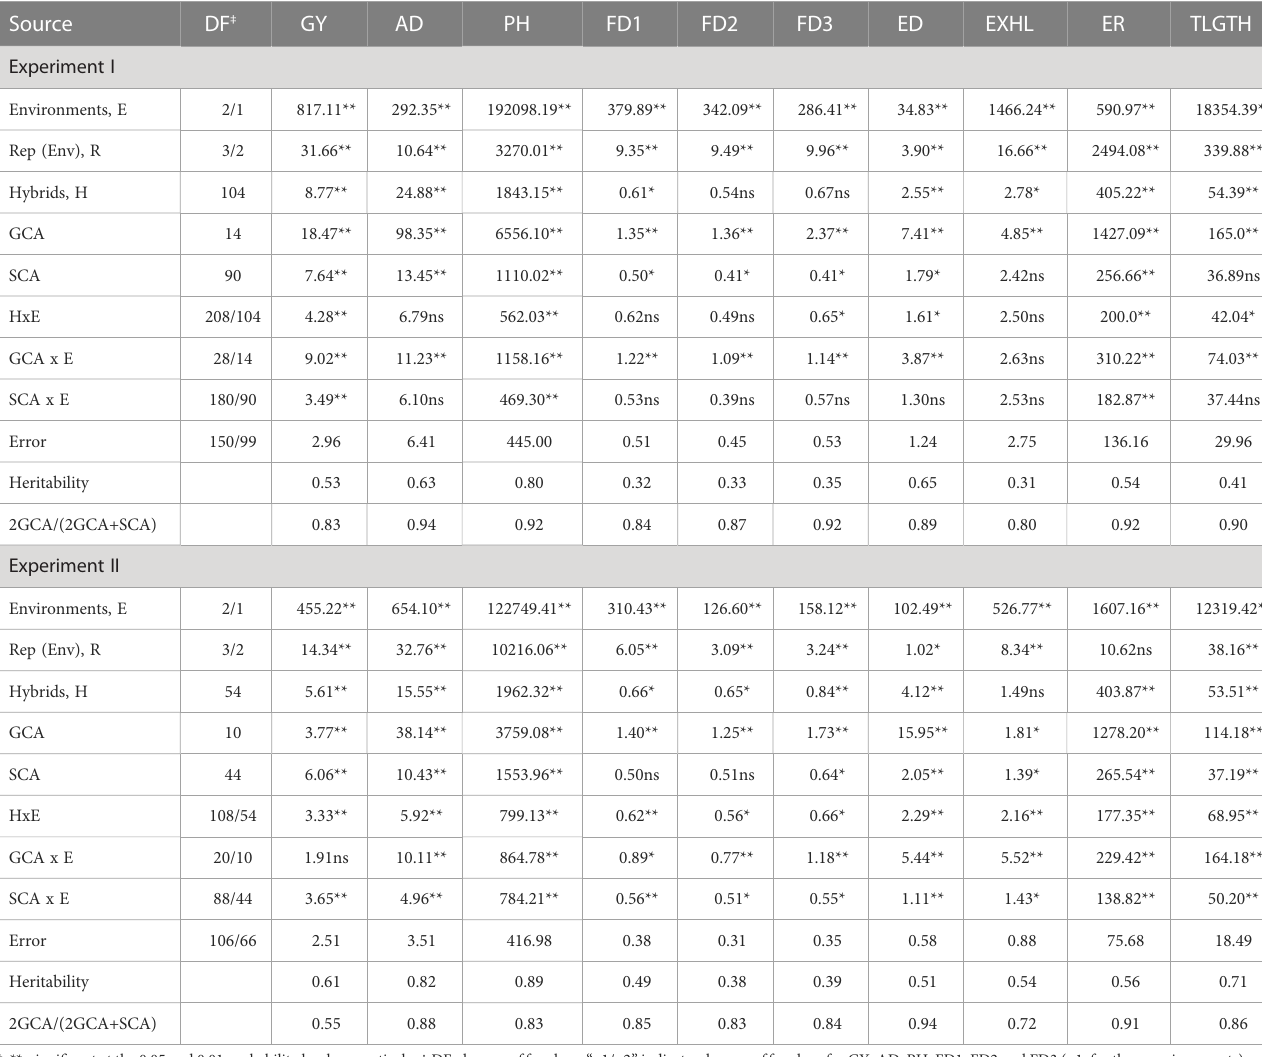
TABLE 3 Mean squares for grain yield and other FAW resistance associated traits of 160 medium maturing tropical maize hybrids evaluated in two diallel experiments under arti fi cial FAW infestation in Kiboko, Kenya.